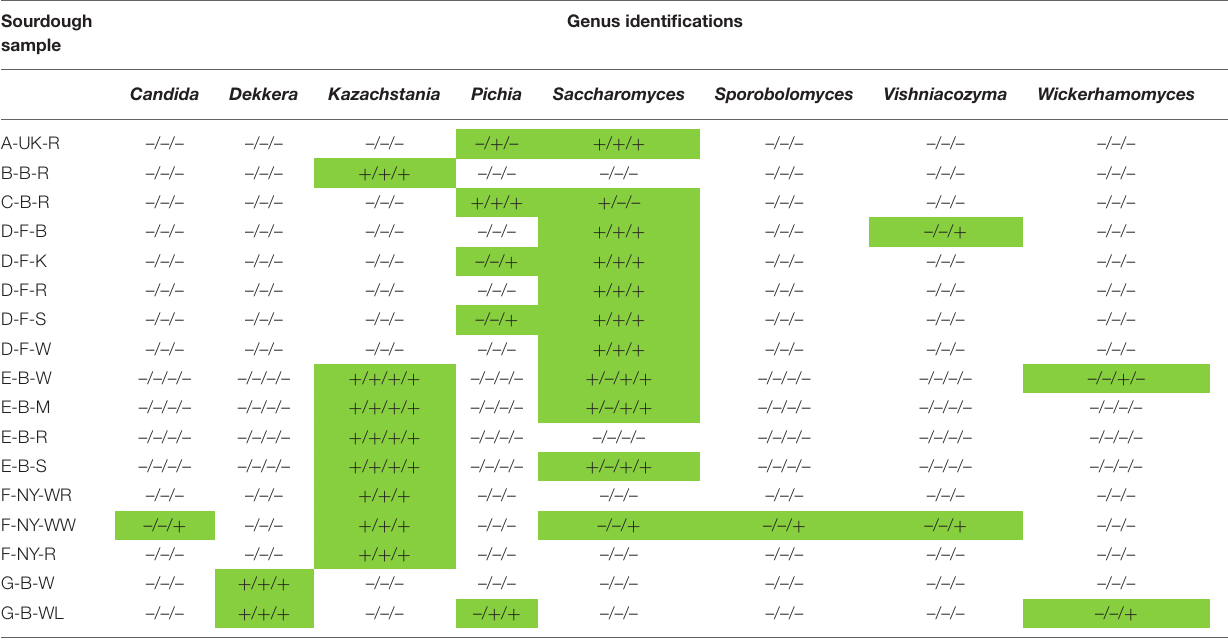
TABLE 6 | Comparison of the culture-dependent and culture-independent identifications of yeast genera in 17 sourdough samples from backslopped sourdoughs of different origins, indicated as presence ( + ) or absence (–) through colony identification, rRNA-PCR-DGGE, metagenetics, and metagenomics (only producer